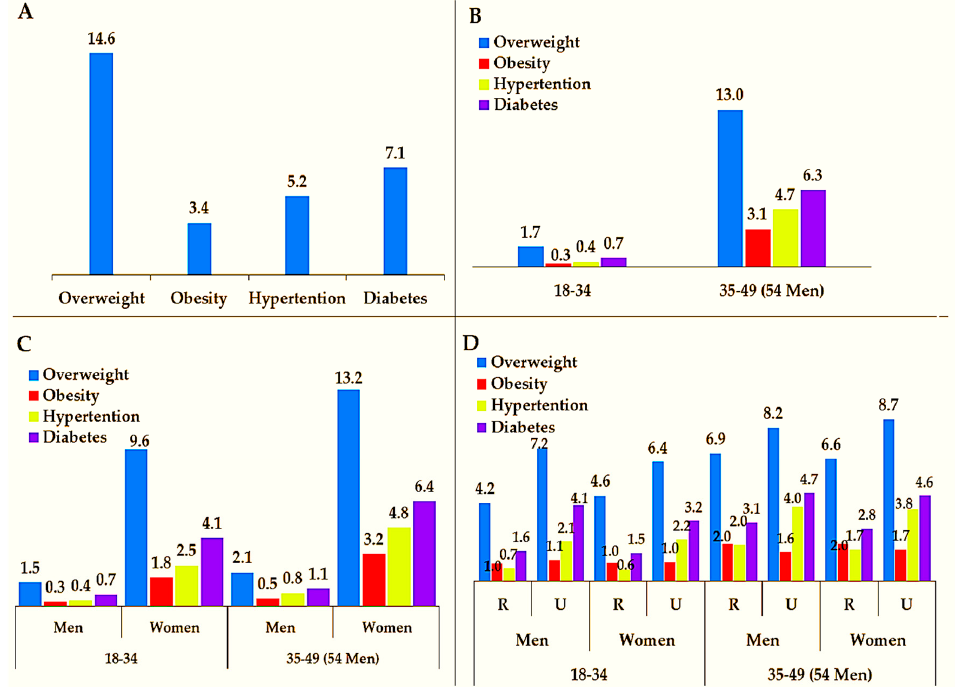
Figure 2. The national prevalence of overweight, obesity, hypertension, and diabetes among adults by ( A ) disease/condition, ( B ) age group, ( C ) age group and sex, and ( D ) age group, sex, and residence. The prevalence presented in percentages. Int. J. Environ. Res. Public Health 2019 , 16 , x